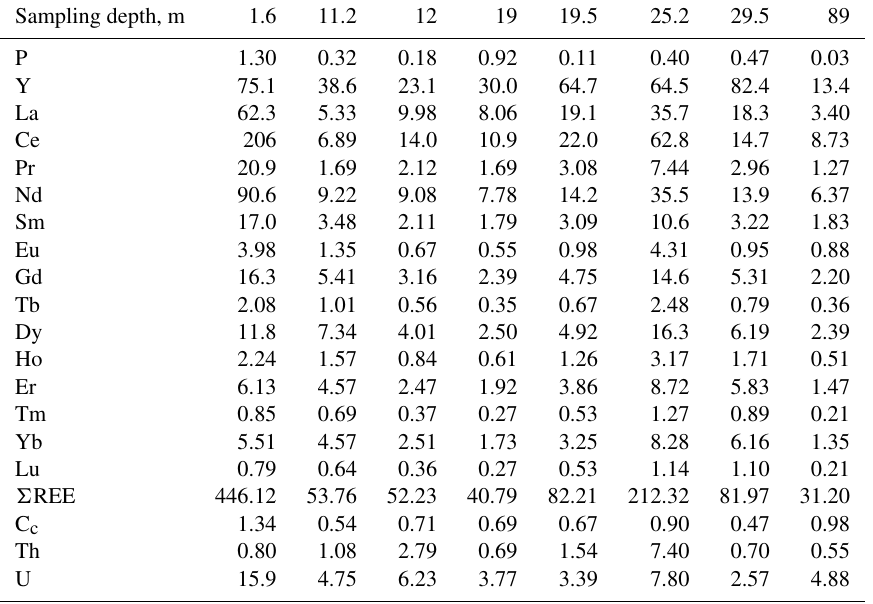
Table 2. Content of P (wt%), Y, REEs, U and Th (ppm) of the brown iron ore and possible precursor calcareous volcanomictic rock (89m).